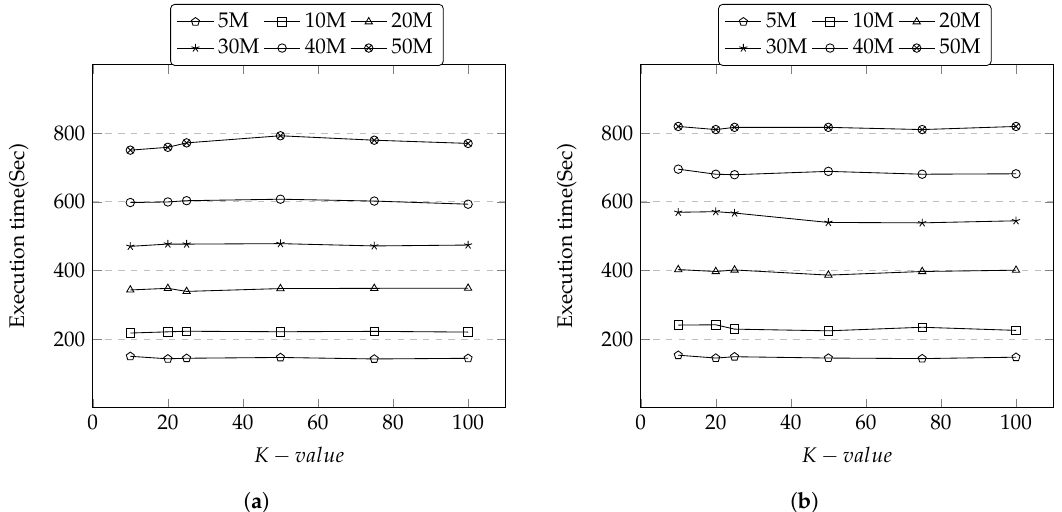
Figure 11. Execution Time vs. Record Size. ( a ) Adult Dataset; ( b ) Irish